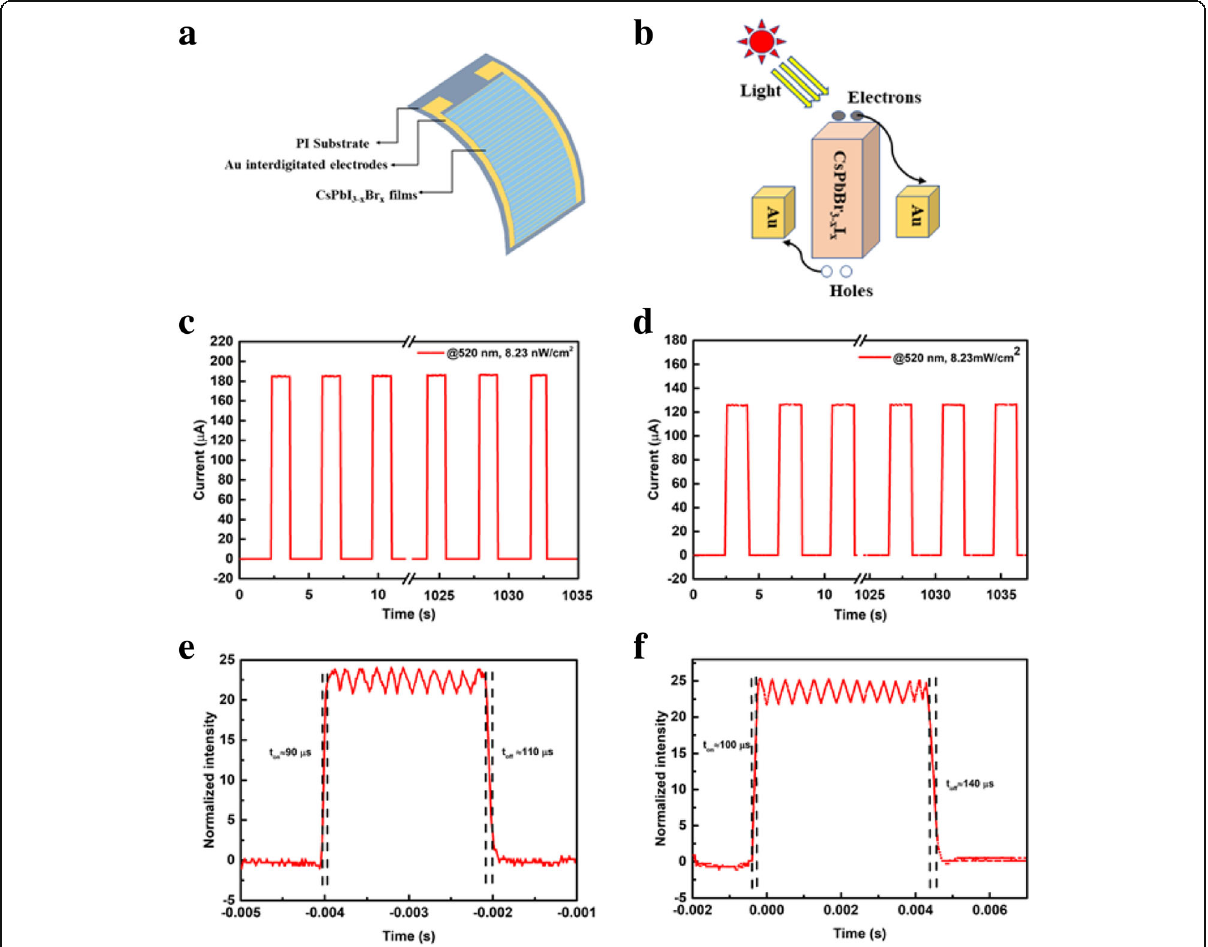
Fig. 3 a Device structure of the CsPbI 3-x Br x flexible PDs . b Schematic diagram of charge carrier transport in the device under illumination. I – t curves of the c